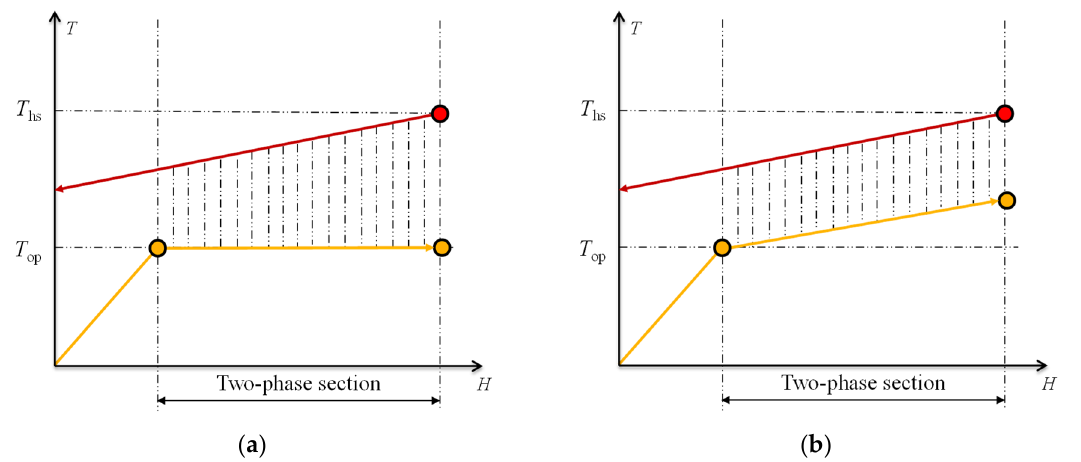
Figure 20. Heat exchange process between working fluid and heat source in evaporator of the ORC: ( a ) pure fluid; and ( b ) zeotropic mixture.